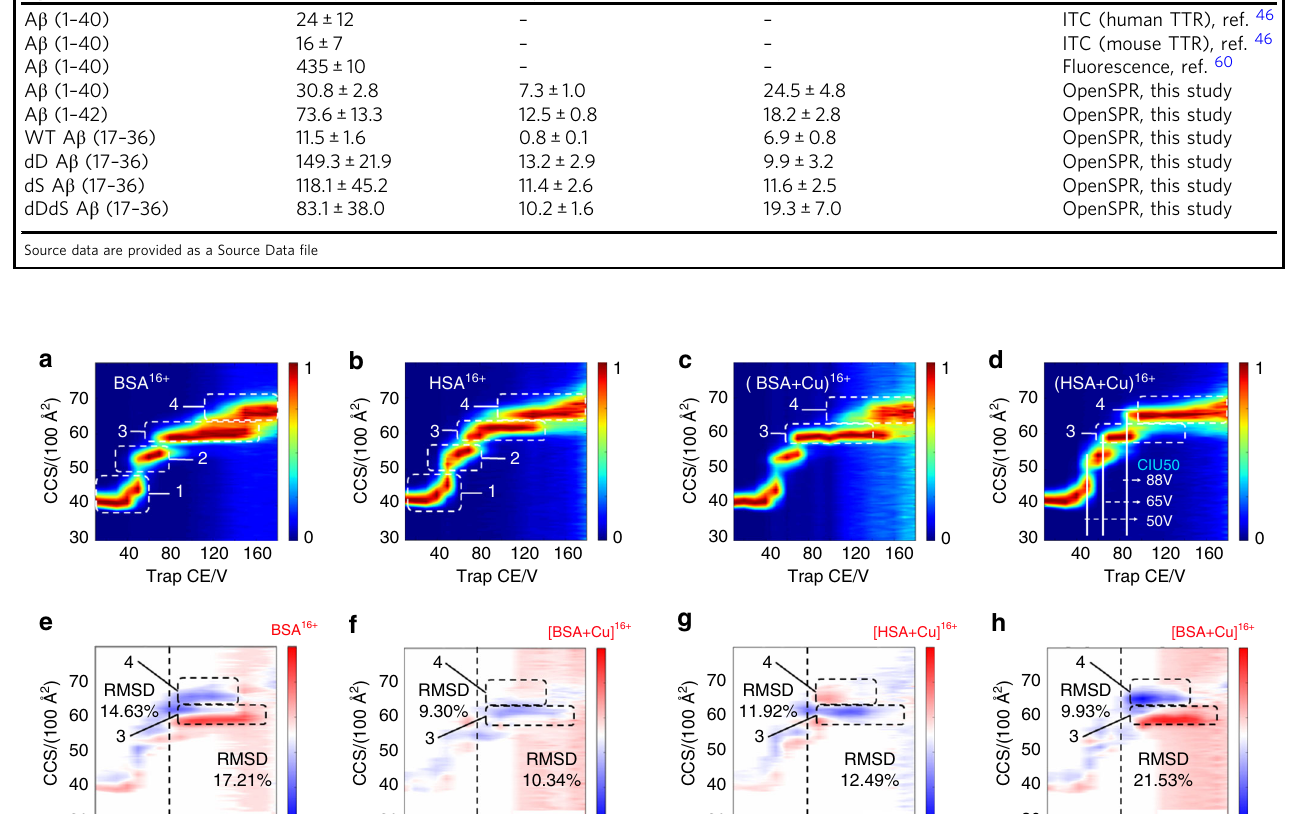
Table 2 In-solution kinetics analysis of chiral TTR-A β interactions via OpenSPR (All data in this study represent average values from three biologically independent samples, ± indicates SD) A